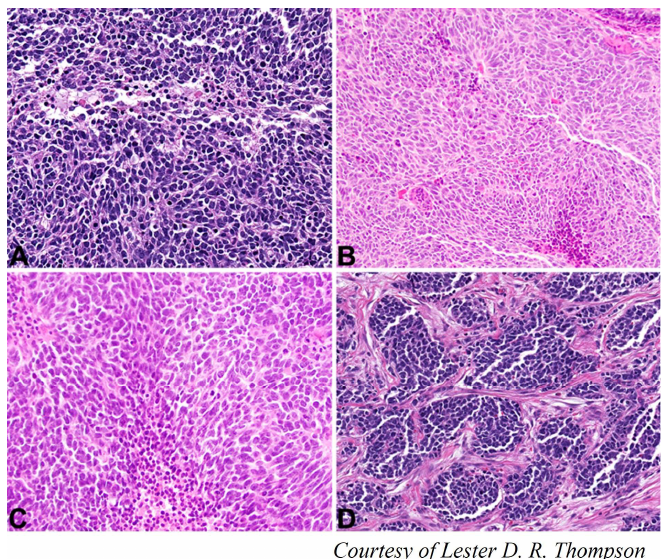
Figure 8. Primary Malignant Thyroid Teratoma or Thyroblastoma. Primitive small round to oval cells, disposed into irregularly communicating solid aggregates and sheets with foci of necrosis ( × 200 magnification) ( A – C ). Nests of small round-to-oval cells intermixed with primitive spindle stromal cells (×200 magnification) ( D ) .